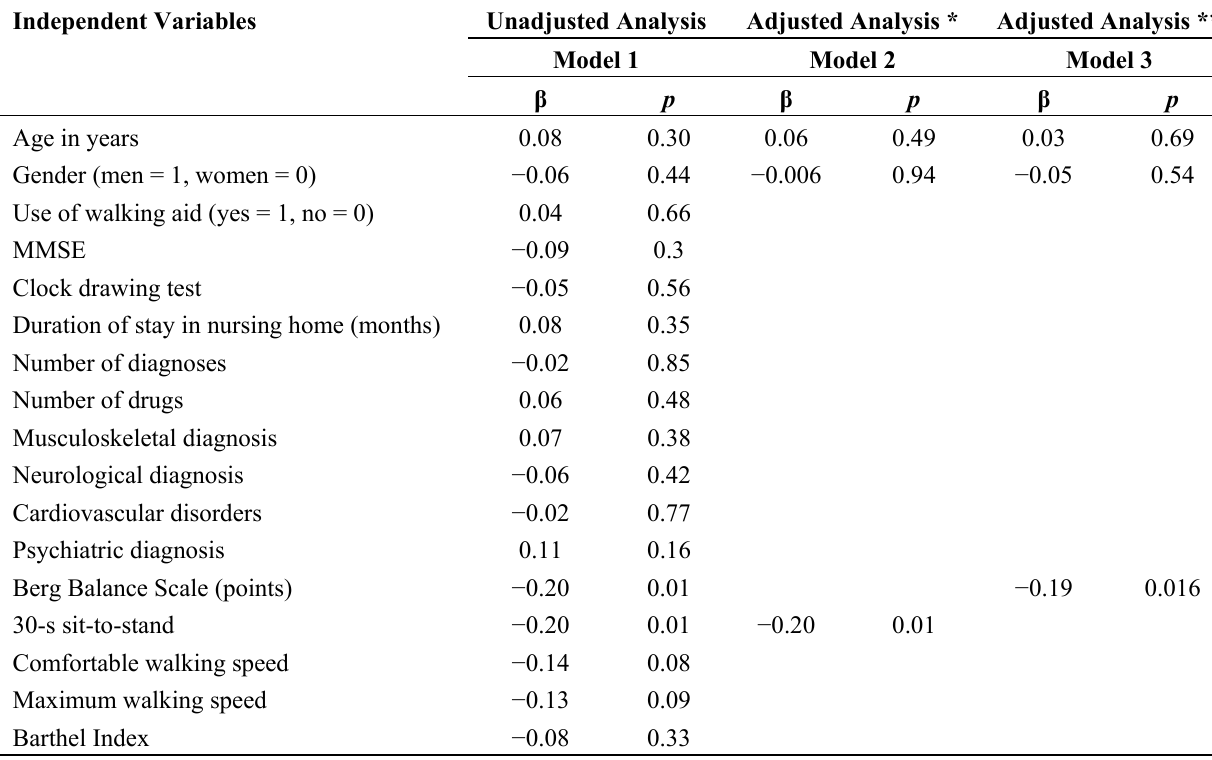
Table 3. Linear unadjusted and adjusted regression analyses * of the association between QUALID (dependent variable) and variables measuring demographic factors, health and physical